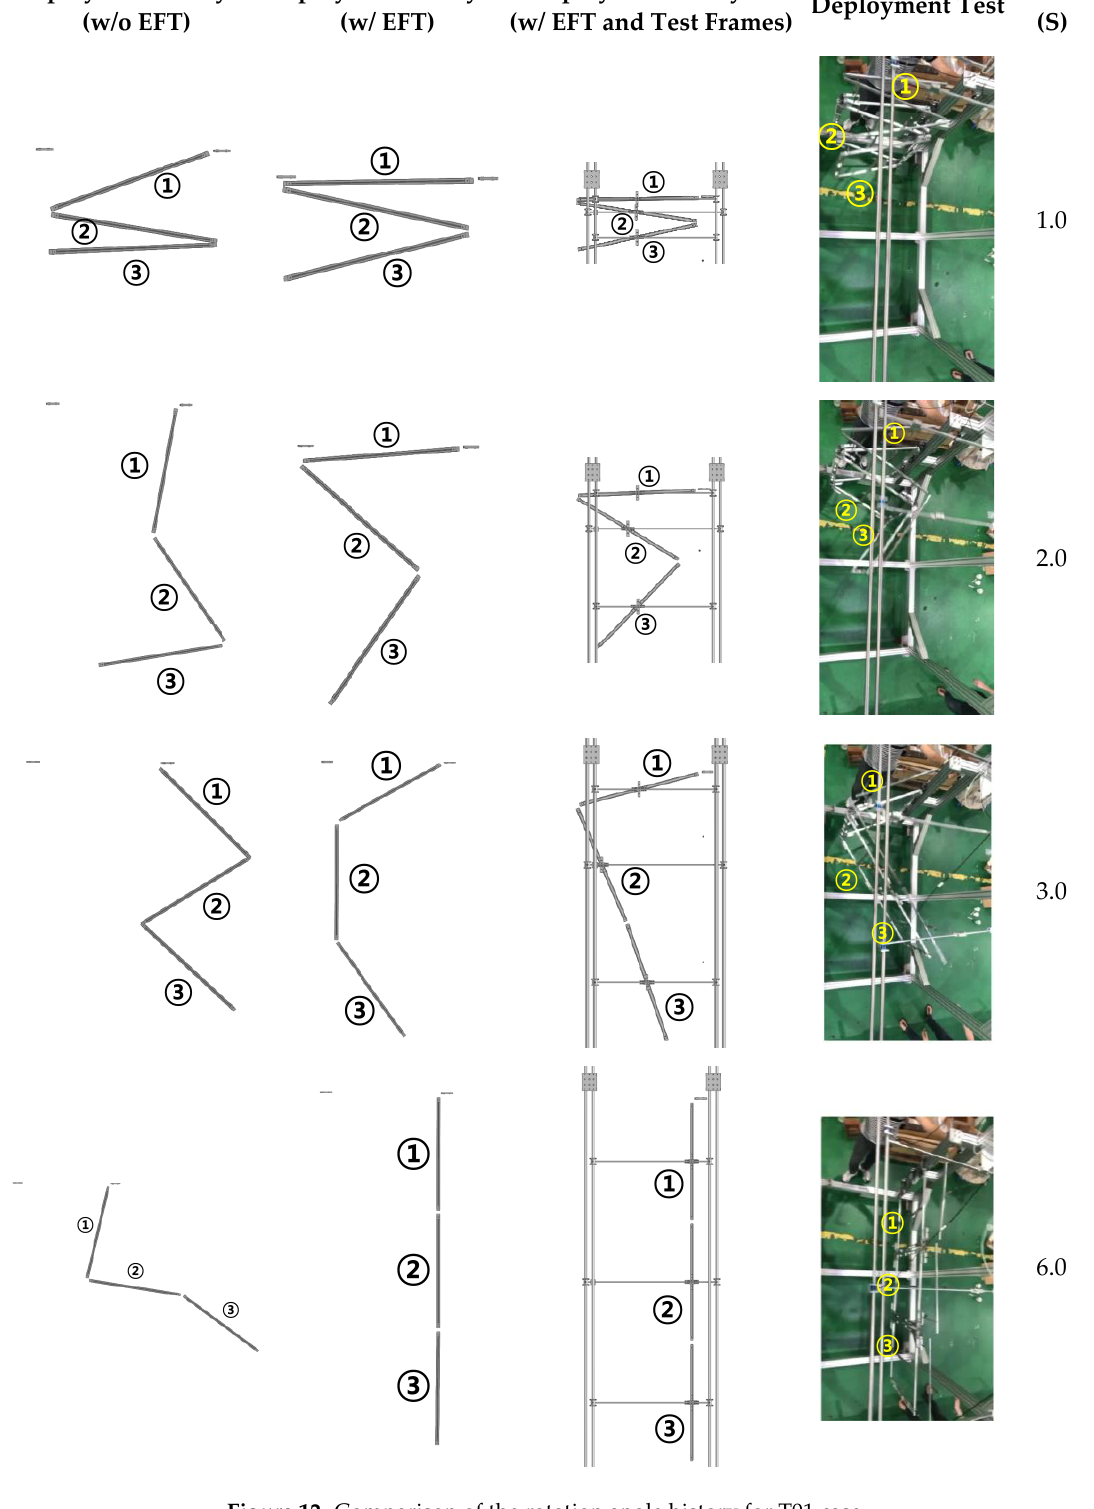
Figure 12. Comparison of the rotation angle history for T01 case.